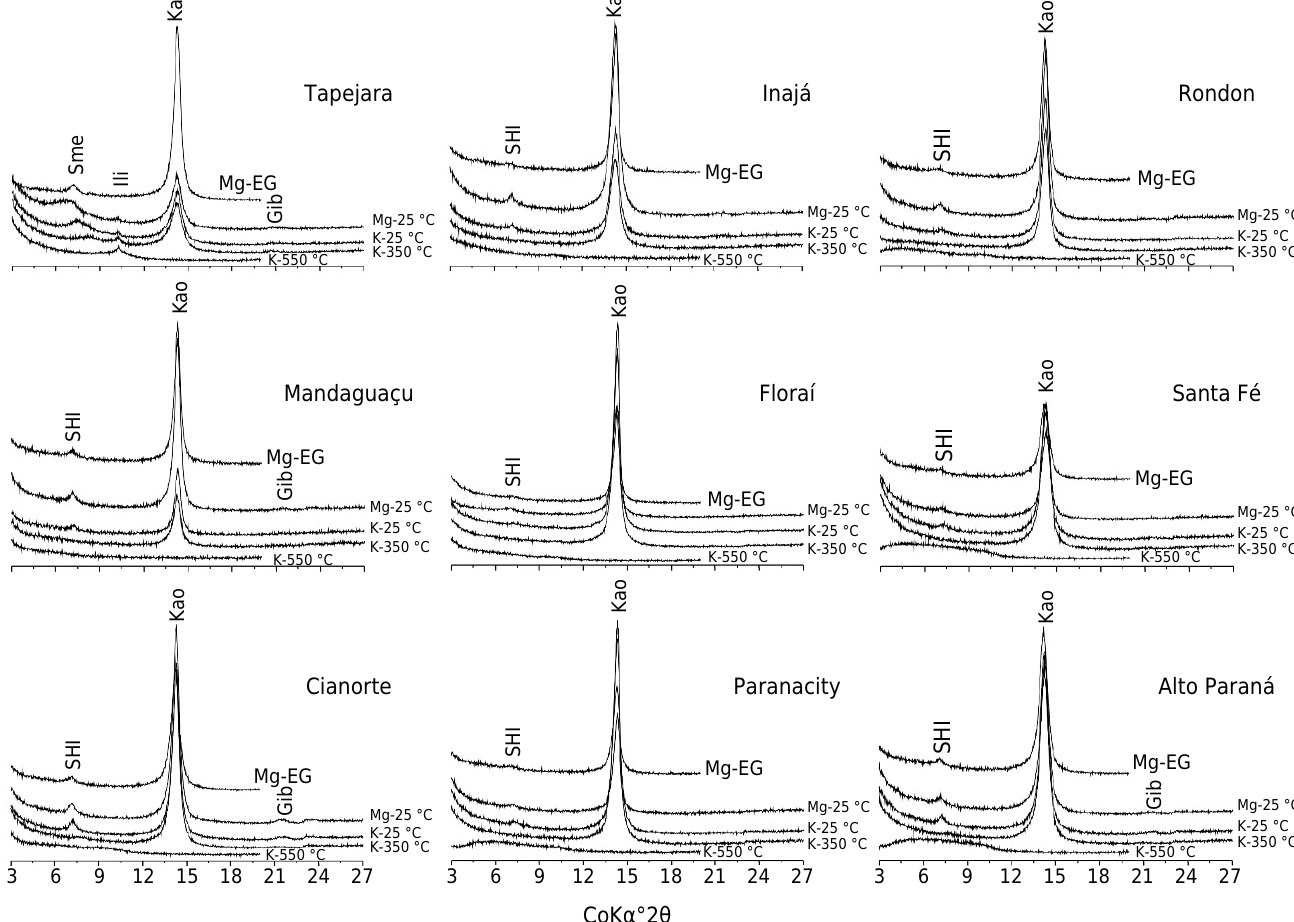
Figure 2. X-ray diffraction patterns of the DCB-treated clay fraction of selected soil samples from Tapejara, Mandaguaçu, Cianorte, Inajá, Floraí, Paranacity, Rondon, Santa Fé, and Alto Paraná counties. Sme: smectite; SHI: smectite with Al-hydroxy-interlayered; Kao: kaolinite; Ili: